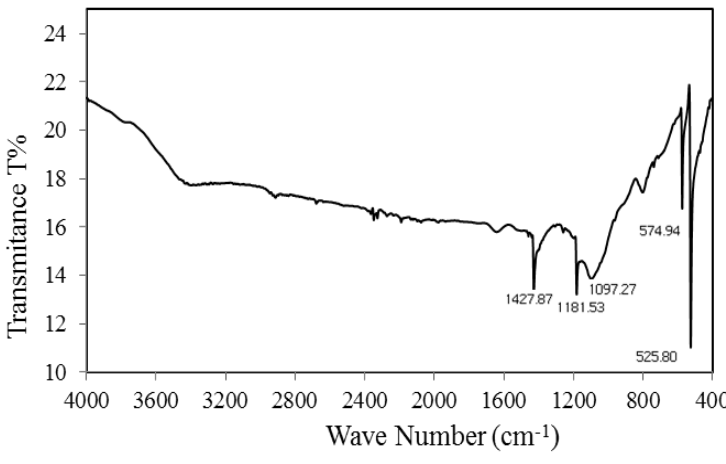
Figure 1. FTIR spectra of pristine